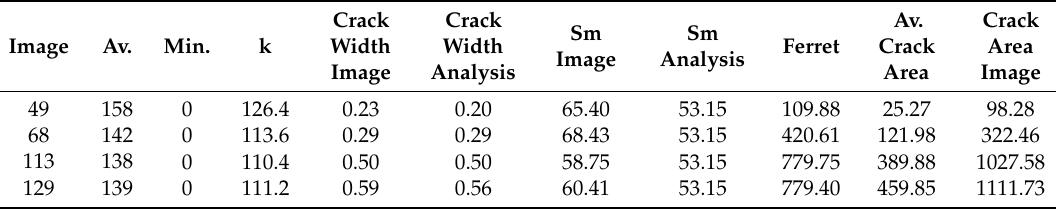
Table 4. Measured and calculated results for Specimen